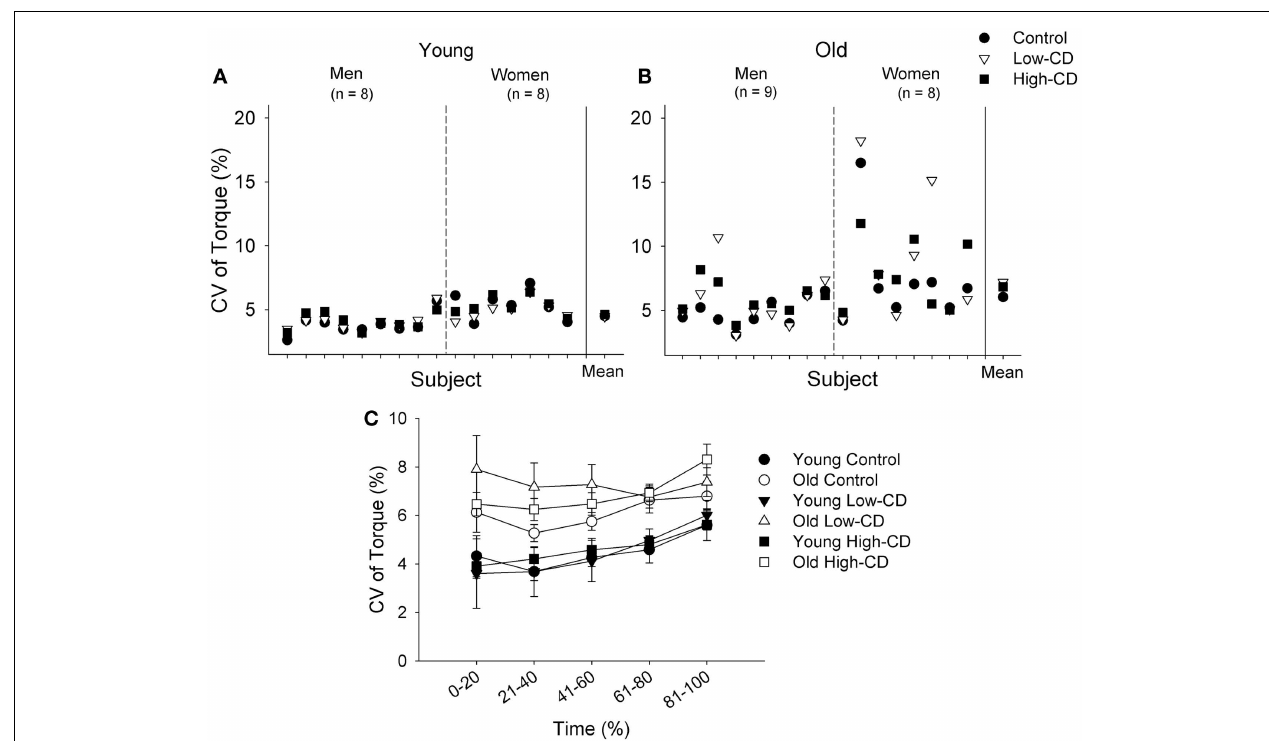
sessions than the young and men respectively ( p < 0.05). In (C) , the CV of torque (mean ± SE) is shown for the control (circle), low-CD demand (triangle), and high-CD (square) sessions for young (closed symbols) and older (open symbols) adults during five continuous intervals of 20% during the fatiguing contraction between 0 and 100% of the time to failure.Thus, the x axis intervals for (C) indicate the interval of data points averaged in each 20% interval. Older adults had significantly higher CV of torque than young adults (age effect, p =